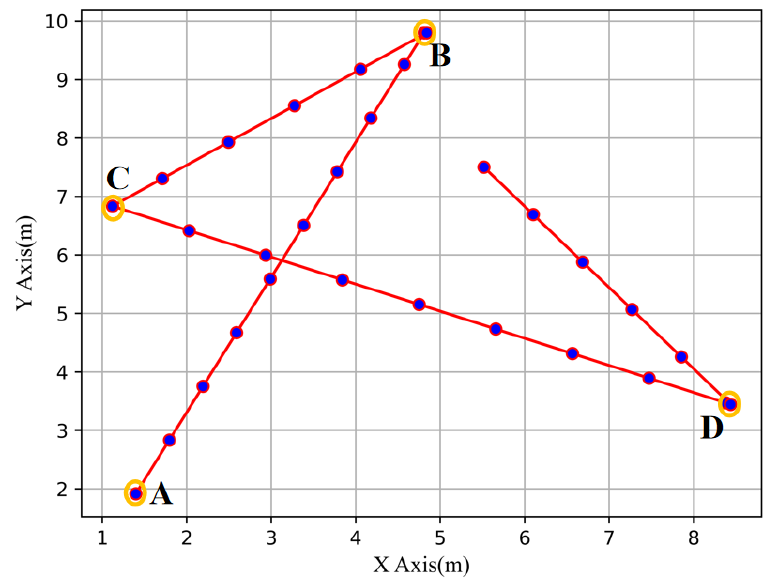
Figure 4. Schematic flow chart of RWP model.